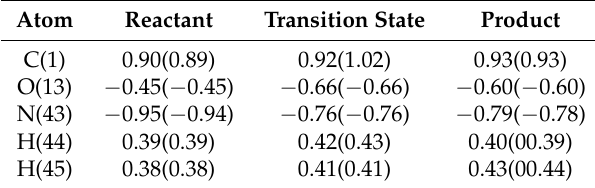
Table 2. ESP charges for selected atoms for the reaction in DCM(GP) for Scheme